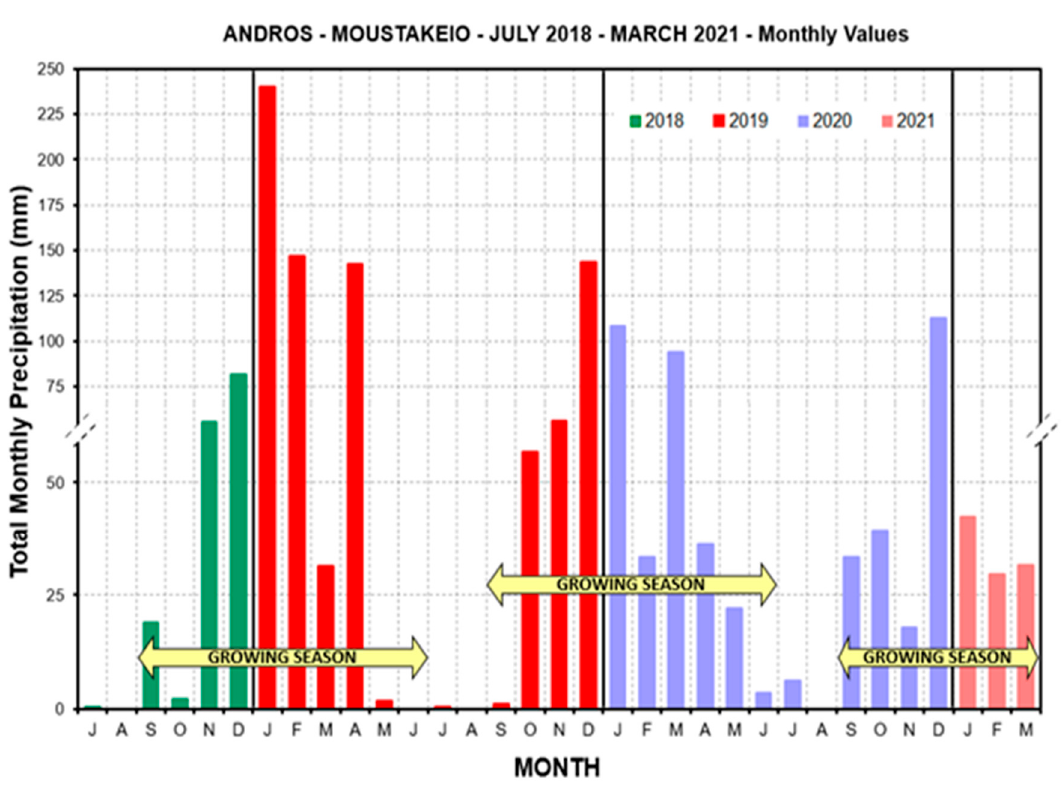
Figure 4. Total precipitation (mm) per month for three cultivating periods (2018–2021) in Andros Island.